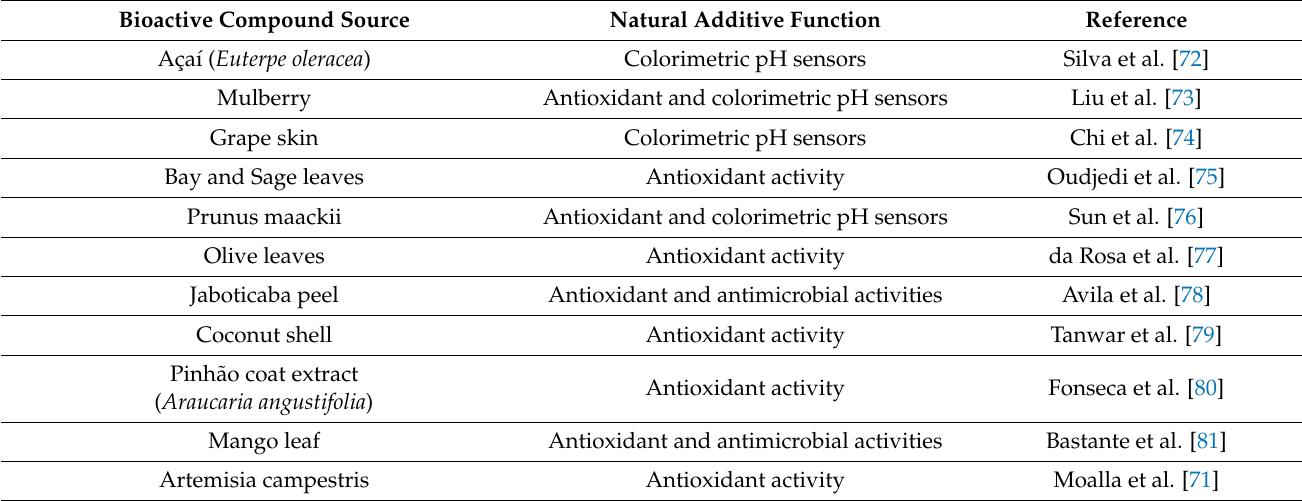
Table 2. Recent works reported in the literature on natural bioactive